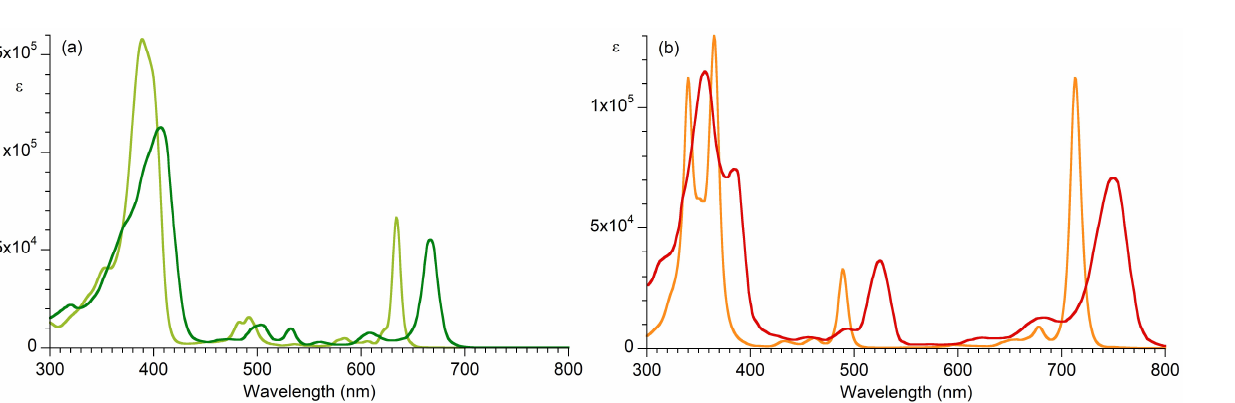
Figure 3. Absorption spectra at room temperature. ( a ) H 2 C (in toluene, lime) [30,33] and pheophytin a (in Et 2 O, green) [32]. ( b ) H 2 BC (in toluene, orange) [31] and bacteriopheophytin a (in benzene, red) [32].